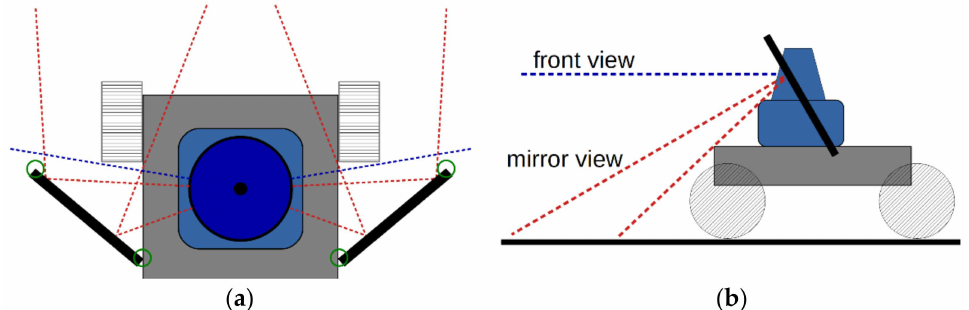
Figure 2. ( a ) Top view and ( b ) side view of the geometry for the geometric design simulations. In the center of the image, the 2D-Lidar sensors can be seen (blue). The black lines represent the two plane mirrors. The green circles at their ends have a diameter corresponding to the light receiving aperture of the Lidar sensor. The red lines represent the light beams, or observation directions, of the Lidar sensor. They all originate from the center point inside the